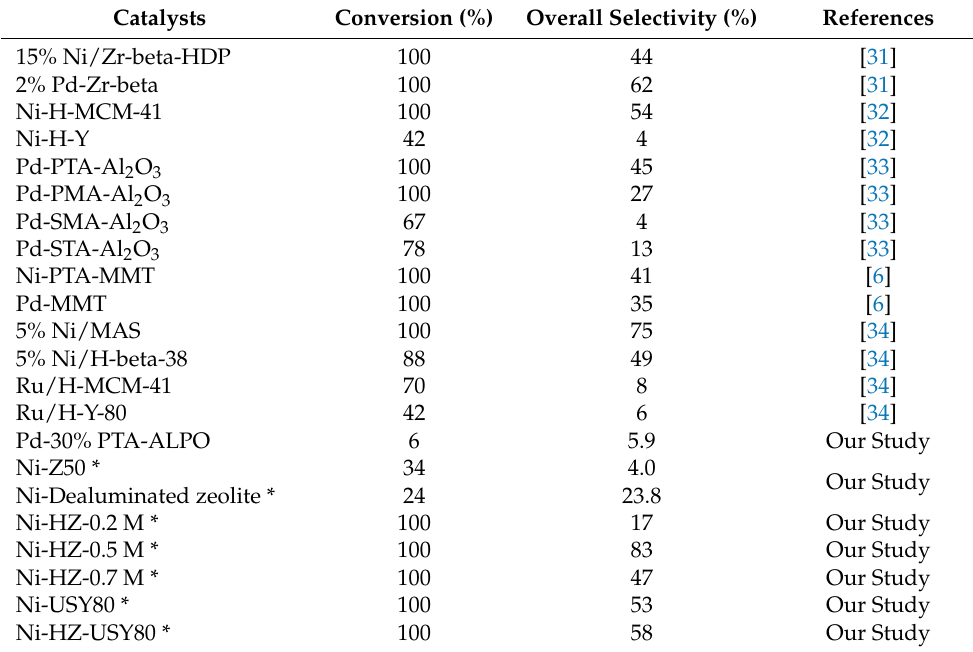
Table 6. Catalytic performances of different bifunctional catalysts in menthol